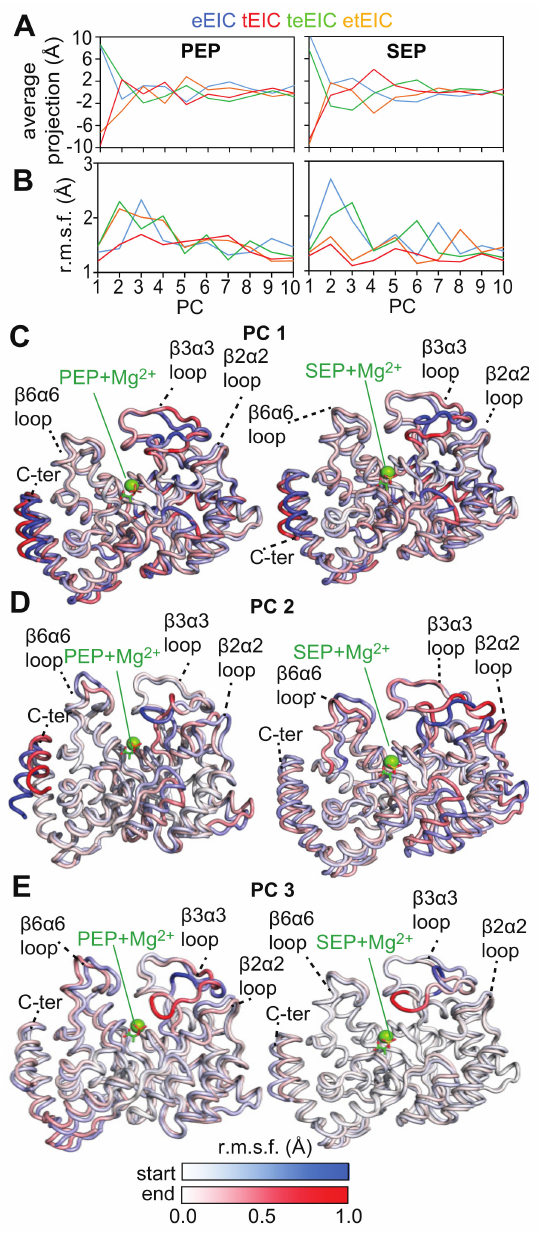
Figure 7. ( A ) Average projection and ( B ) root mean square fluctuations (r.m.s.f.) obtained by pro- jecting the MD trajectories of eEIC (blue), tEIC (red), teEIC (green), and etEIC (orange) bound to PEP (left) and SEP (right) on a common set of PCs obtained from the concatenated trajectory (see Section 4). Combined PCA analysis was performed using the coordinates of the C α atoms of EIC. Results for the first 10 PCs are shown. Panels ( C – E ) show the start (blue) and end (red) points of the pseudo-trajectories describing PC 1, 2, and 3, respectively, for the EIC complexes with PEP (left) and SEP (right). Residue-specific r.m.s.f. values in the eigenvector calculated over the concatenated trajectory are plotted as color gradient on the start and end structures to emphasize the specific contribution of different EIC regions to each PC. The r.m.s.f. versus residue plots for PC 1, 2, and 3 are show in Figure